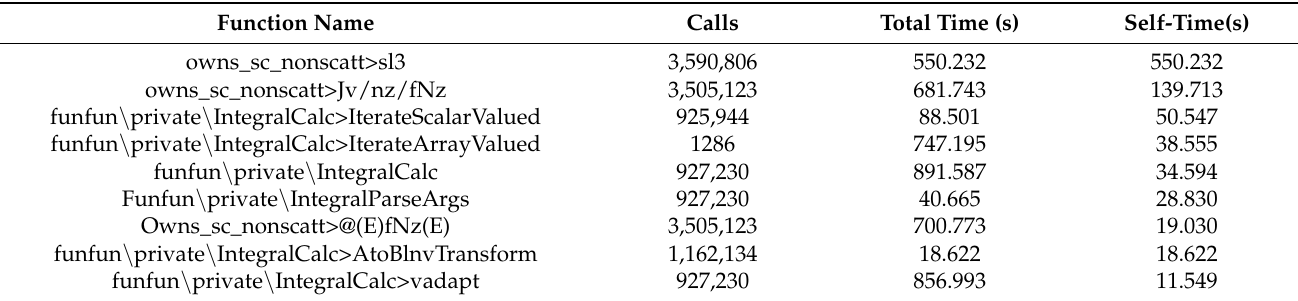
Table 2. Time taken for the calculation of current–voltage characteristics using the ab initio model.